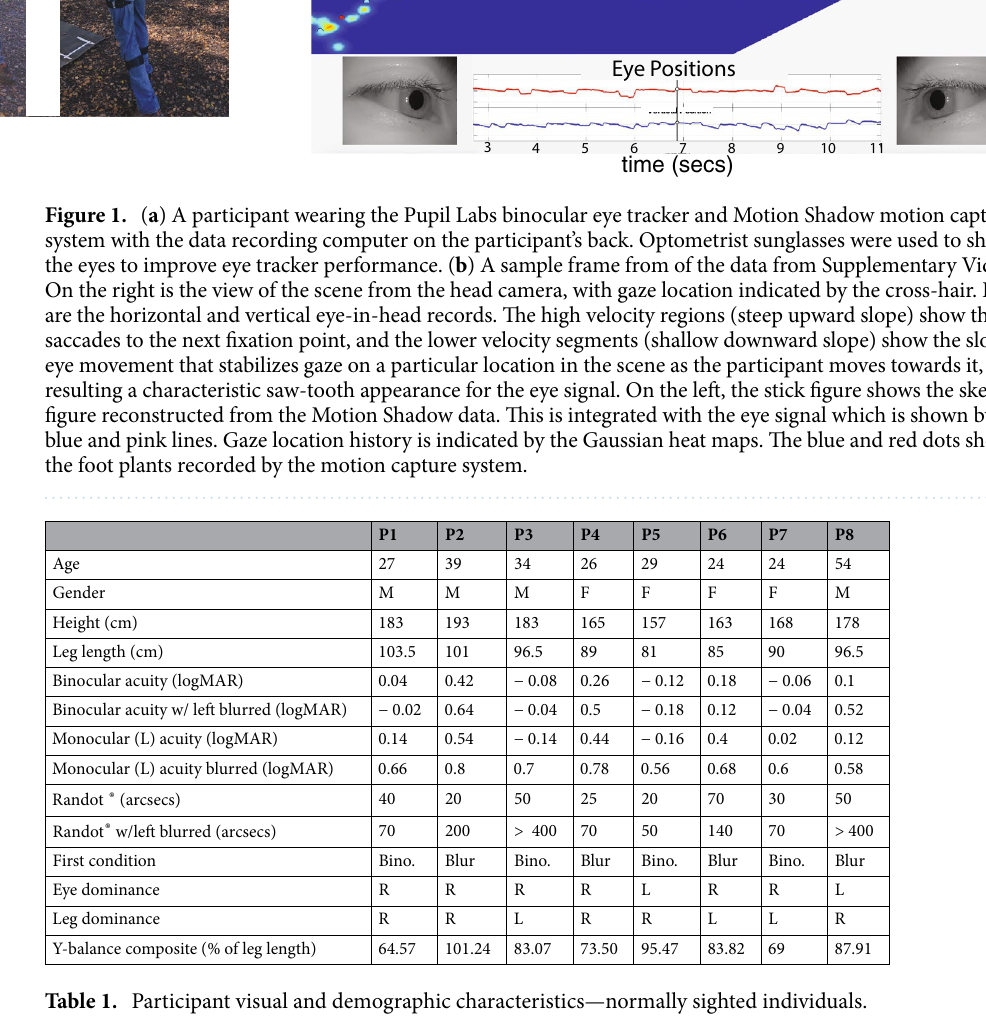
by the red and cyan dots. The gaze vectors for the right and left eyes are shown by the pink and blue lines. Gaze behavior was similar to that described in 12 where participants make high velocity saccadic eye movements from one location to the next along the future travel path, and then stabilizing eye movements (i.e., vestibular ocular reflex, optokinetic nystagmus, and/or smooth pursuit) counter-rotate the eyes to maintains a stable image as the head moves forward. This is indicated by the characteristic saw-tooth pattern shown at the bottom of Fig. 1, where the saccades are indicated by the abrupt shifts in eye-in-head position, and the stabilizing eye movements are indicated by the slow change as the eye counter-rotates to maintain gaze position during the forward movement. Gaze distributions vary with terrain. As reported in 12 , gaze behavior varies with the terrain. Gaze is directed mostly near the body in rough terrain in order to guide foothold selection, and at more distant locations (off the ground) in smoother terrain. This is shown in Fig. 2, which plots the distribution of gaze angles, for the different types of terrain. In the plot, zero indicates gaze at a distant location, parallel to the ground plane. Gaze ◦ angles around − 45 are closer to the walker, when gaze is allocated to the ground near 2–3 footholds ahead. The distributions of gaze angles shift drastically across the terrains. Even the paved road and the flat dirt path lead to distinctly different distributions, suggesting different demands on vision. This might be a consequence of the